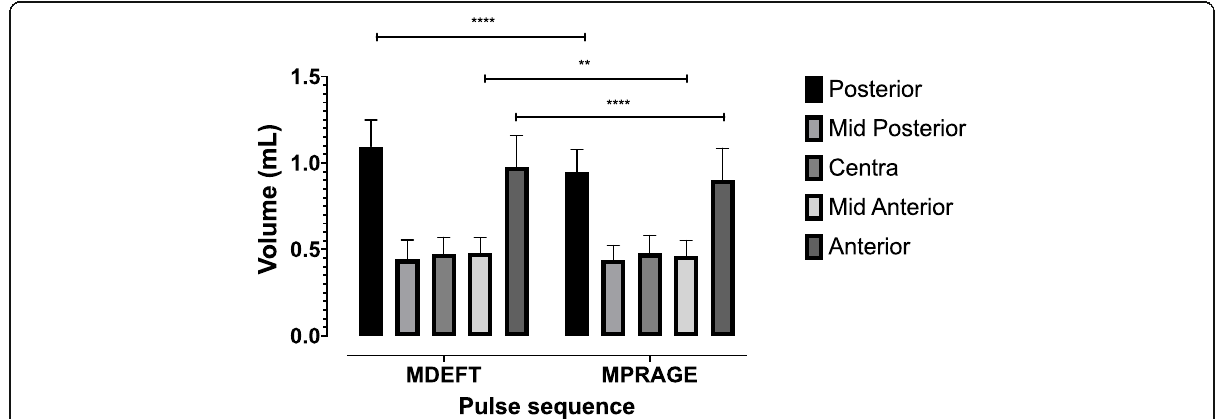
Fig. 5 Mean and standard deviation (SD) of volumetric measurements of CC regions versus pulse sequences (MDEFT and MP-RAGE). Volumes are in mL